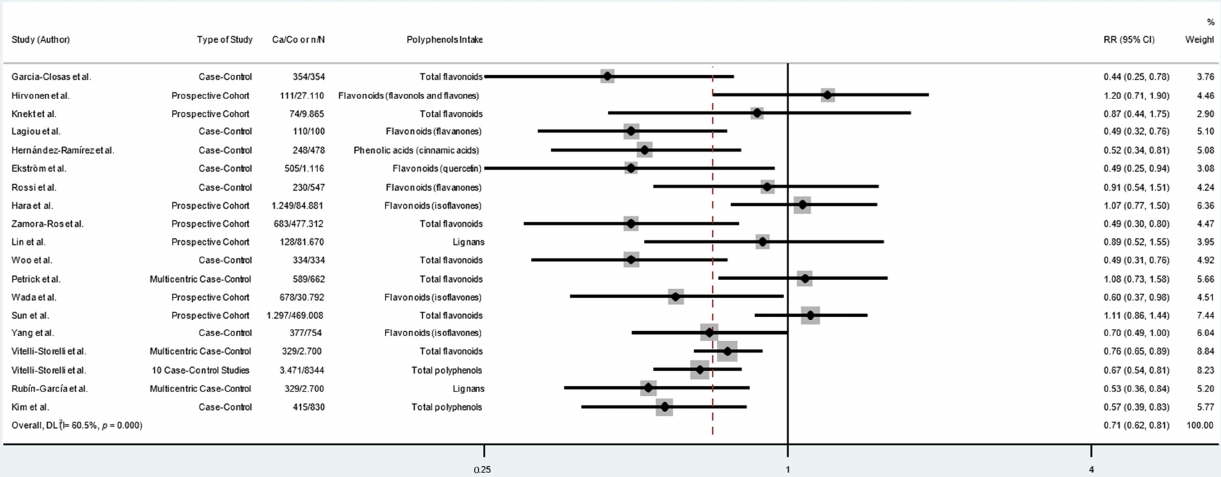
Figure 3. Forest plot of polyphenol consumption and gastric cancer risk. Case–control and cohort studies are presented in chronological order of publication. Square boxes represent study-specific estimates. Markers vary in size according to weight assigned to each study, the size of each box reflects the study’s weight in the analysis, and horizontal lines represent 95% confidence intervals. Diamonds show the pooled effect. Abbreviations: RR, relative risk; Ca, number of cases; Co, number of controls; n, number of events; N, number of patients [4,5,8–16,25–32].